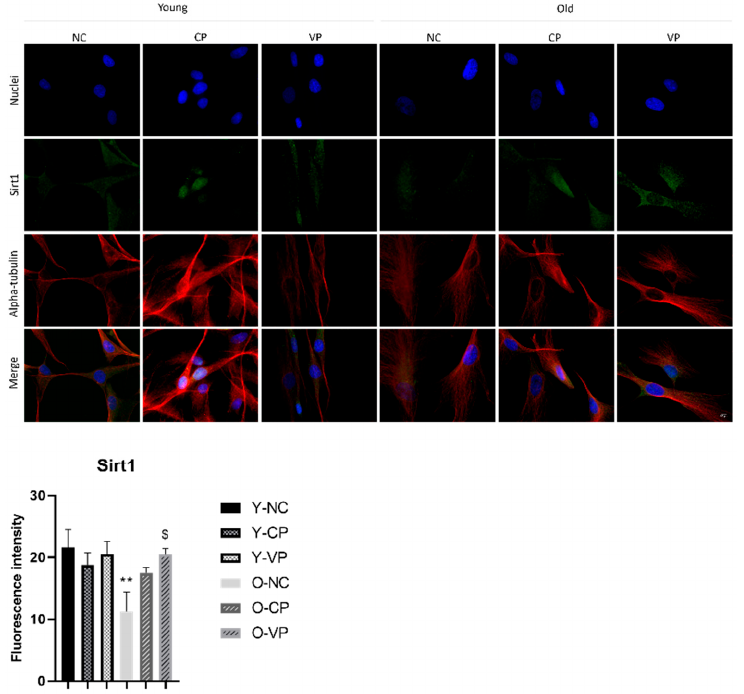
Figure 9. Double immunolabeling for SIRT1 (green fluorescence) and α -tubulin (red fluorescence); DNA was stained with Hoechst 33258 (blue fluorescence). 60× magnification; scale bar: 10 μ m. Histograms representing the analysis of SIRT1 fluorescence intensity; Anova one-way test: p = 0.02; ** p < 0.01, statistical significance between old NHDF untreated and young NHDF untreated; $ p < 0.05, statistical significance between old NHDF treated with VP and old NHDF untreated.